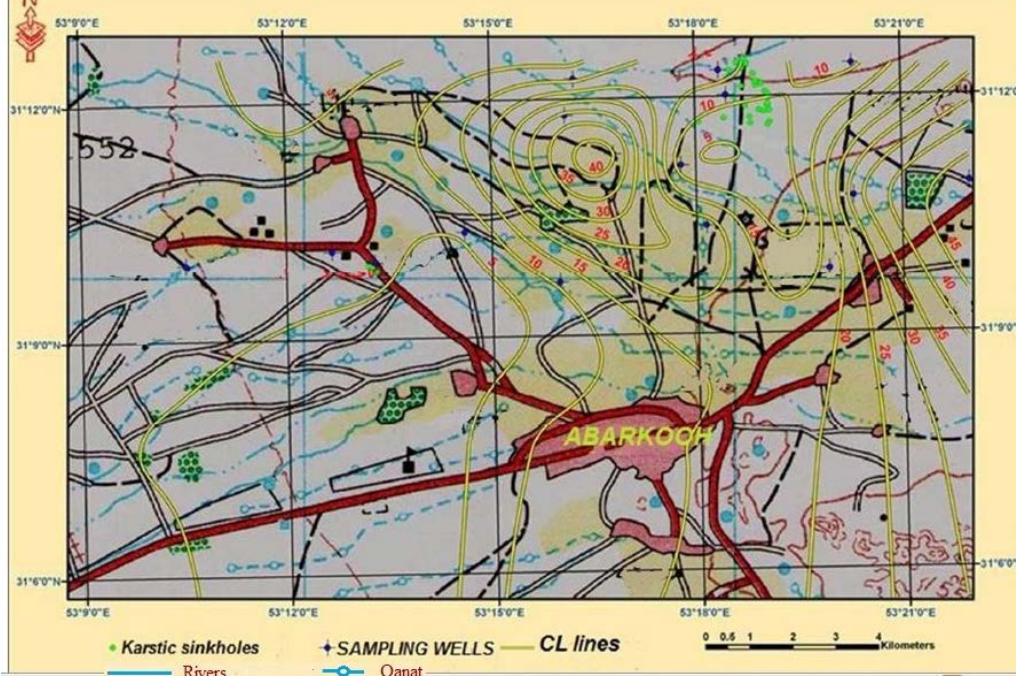
Figure 14. Contour lines of the chloride concentrations in groundwater in mg / L in the Abarkooh